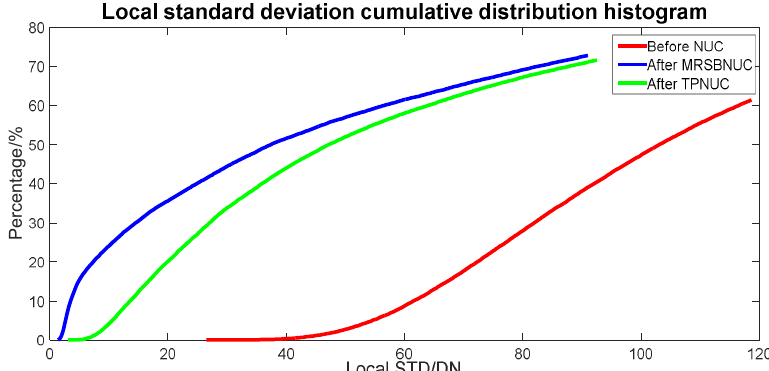
Figure 15. Local standard deviation cumulative distribution of sky scene with clouds: before NUC, after TPNUC, and after MRSBNUC.